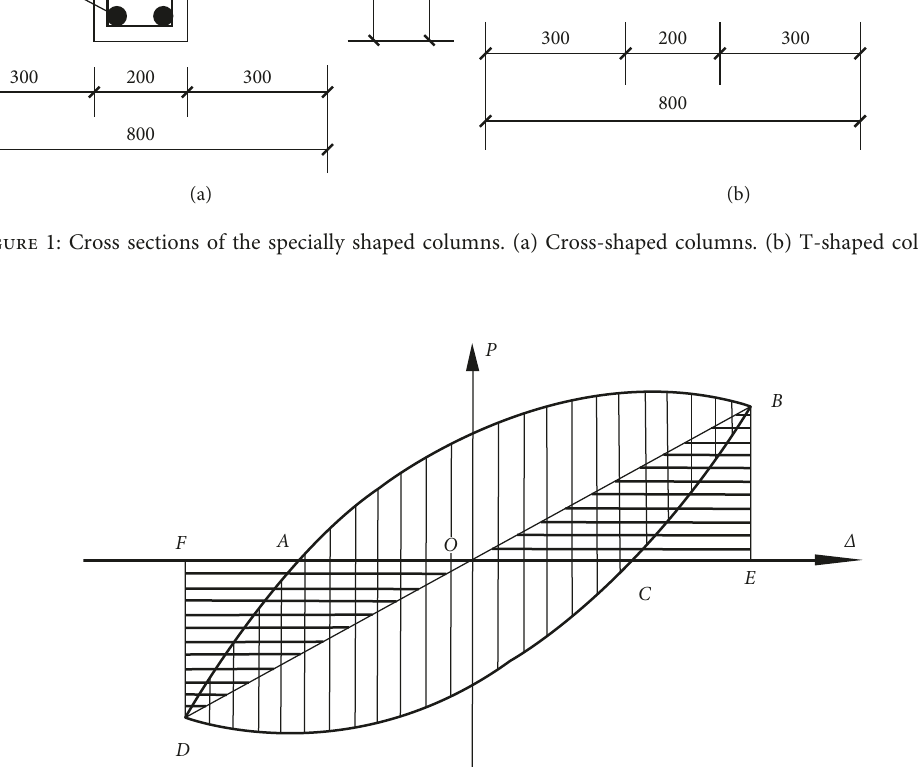
Figure 2: Load-displacement hysteresis energy dissipation